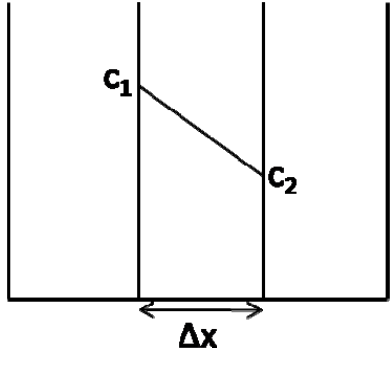
Figure 11. Schematic sketch of the concentration distribution